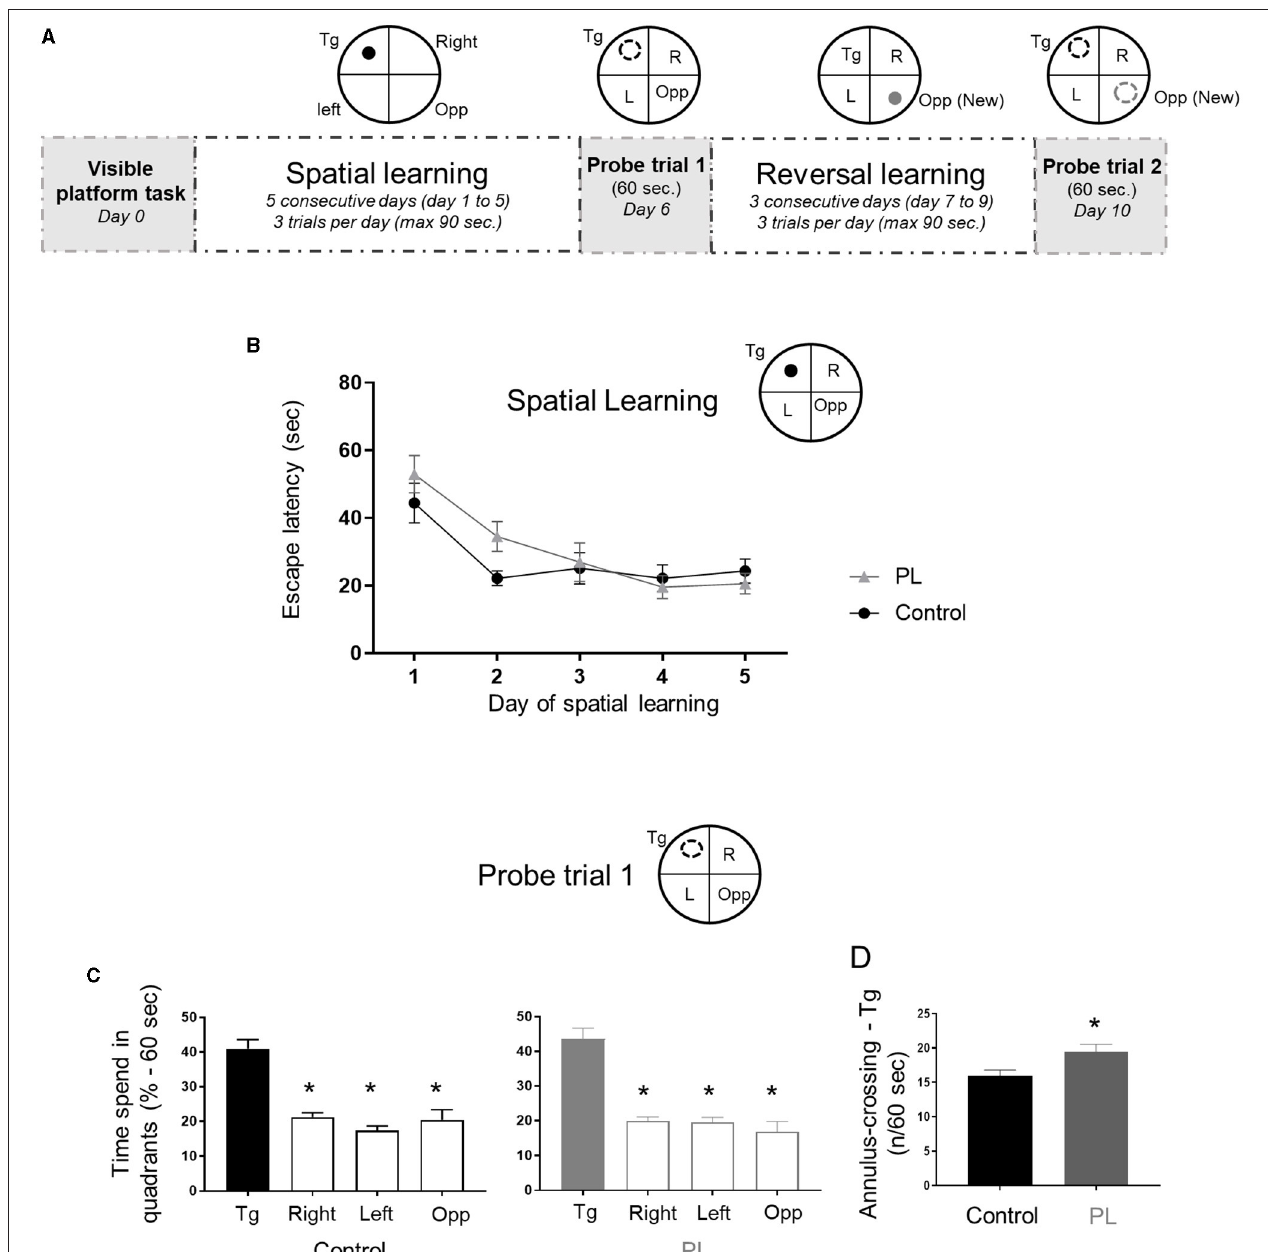
FIGURE 1 | Spatial learning and target long-term memory. (A) Experimental timeline, 2 experimental groups ( n = 14 males) were tested in the Morris water maze test to assess spatial learning and reversal learning performances. Animals supplemented with polar lipids (PL) showed similar learning performances than control animals during (B) the initial spatial learning as shown by the decreased time to find the escape platform. (C) During the probe trial 1 both groups spend significantly more time in the target quadrant compared to the other three quadrants (Tg, * = P < 0.05 for each quadrant compared to quadrant Tg). (D) During the probe trial 1, PL animals showed a higher number of annulus crossing than control animals (* = P < 0.05). All data are expressed as mean ± SEM.